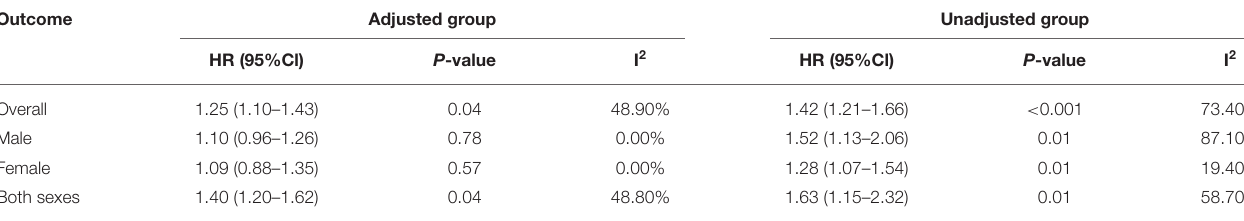
TABLE 1 | Pooled estimates from random effects meta-analysis, expressing the HR of risk of lung cancer.